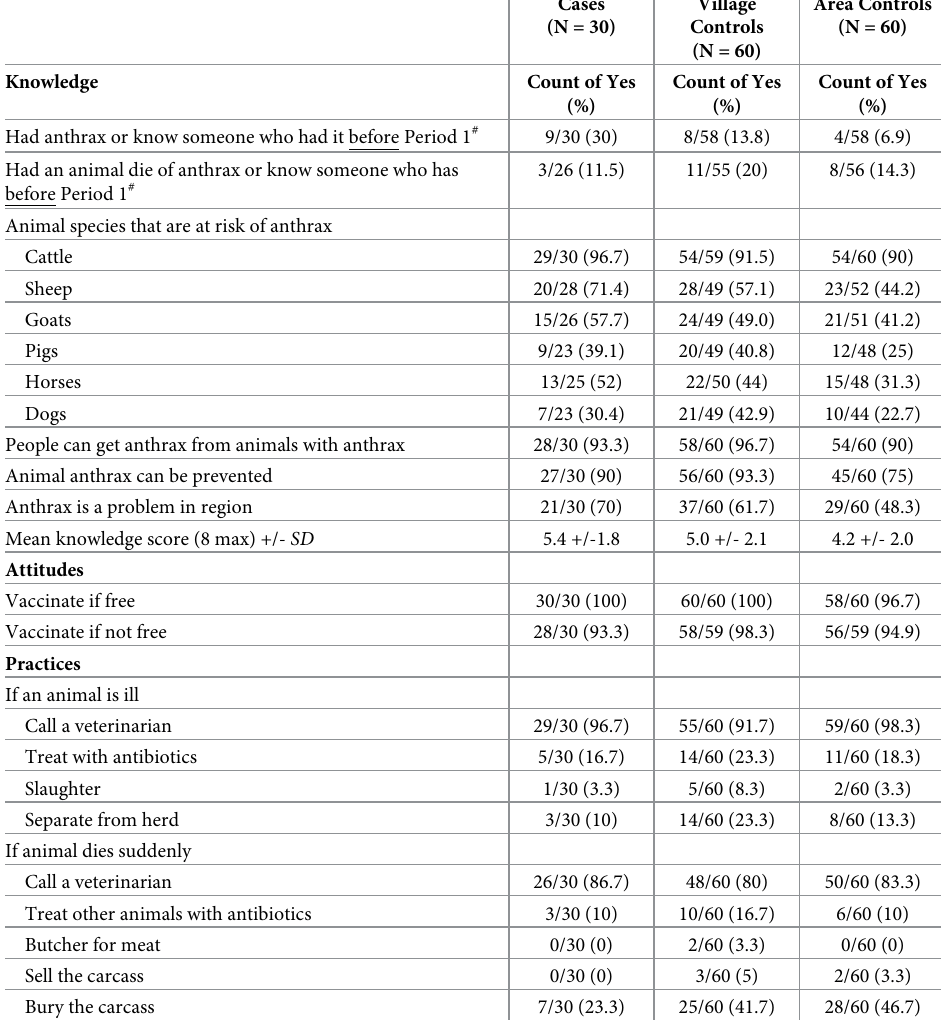
Table 2. Knowledge, attitudes, and practices of handlers of cattle with anthrax (‘Cases’) and handlers of matched uninfected cattle (‘Controls’) in Georgia, June 2013–May